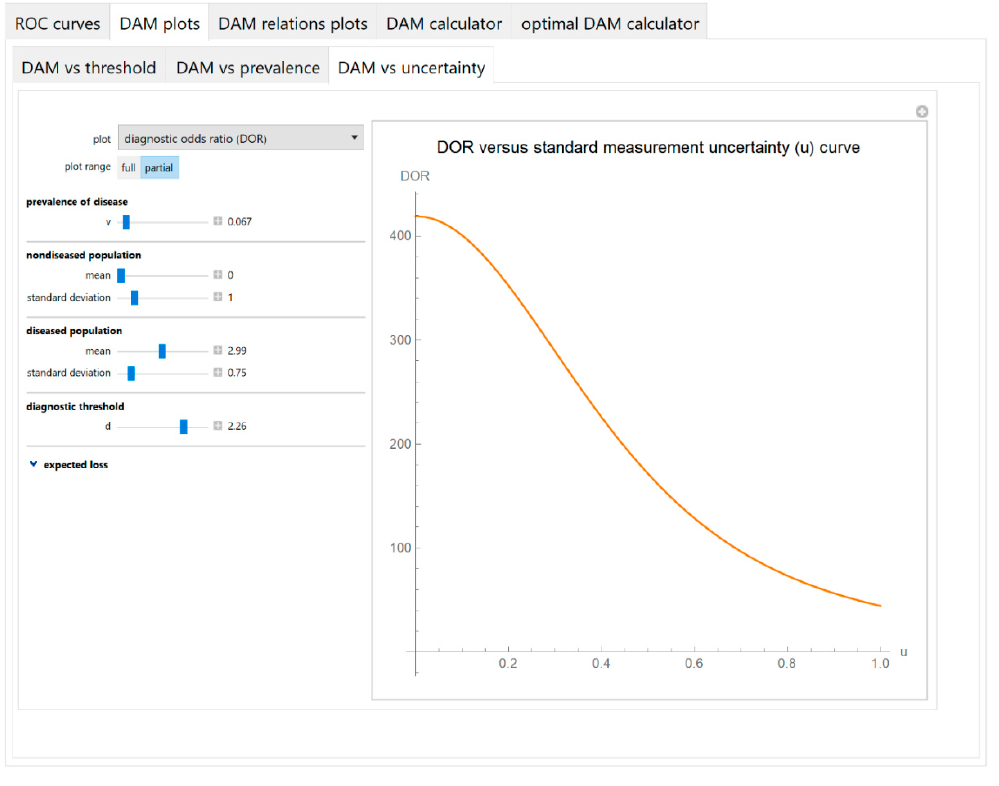
Figure 6. DAM plots module, DAM against uncertainty submodule screenshot. Diagnostic odds ratio ( DOR ) against standard measurement uncertainty ( u ) curve plot with the settings shown at the left.